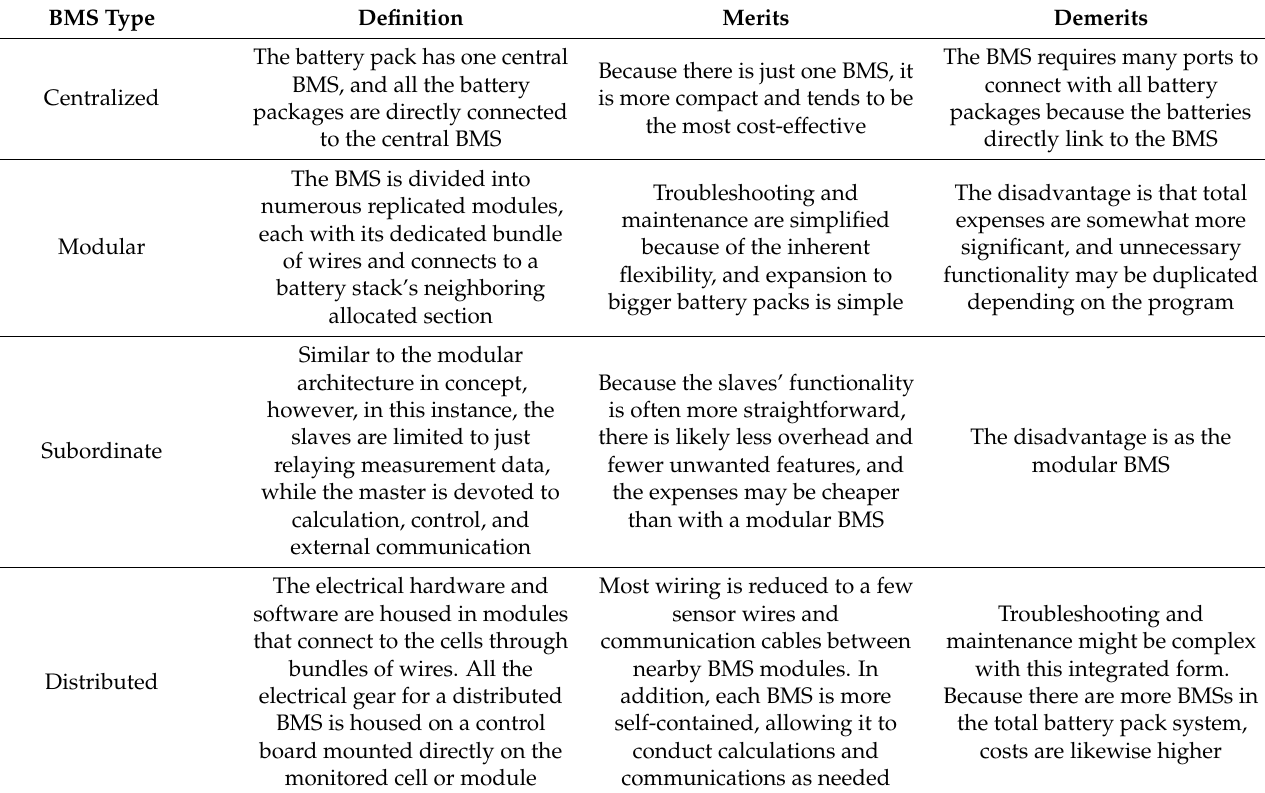
Table 1. Merits and demerits of four topologies of BMS in EV